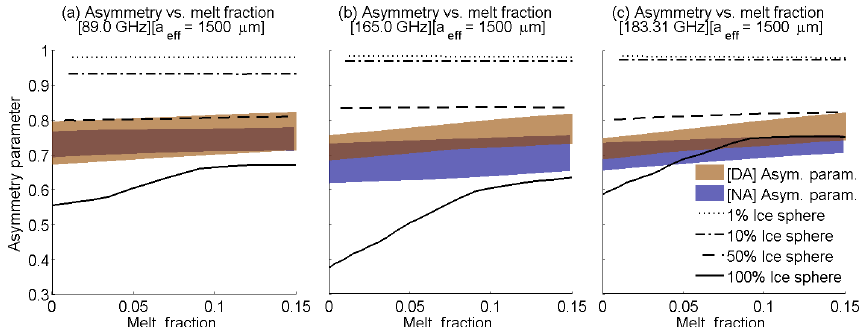
Figure 10. Following Figs. 8 and 9, the scattering asymmetry parameter (indicating the degree of forward scattering) is shown here. At all frequencies, the asymmetry parameter is relatively insensitive to the early stages of melting, consistent with the fact that the overall structure of the melting particles does not change too much over this range. In panel (a) , the asymmetry for NA (blue region) is fully encompassed by the asymmetry from DA, with partial overlaps in (b, c)